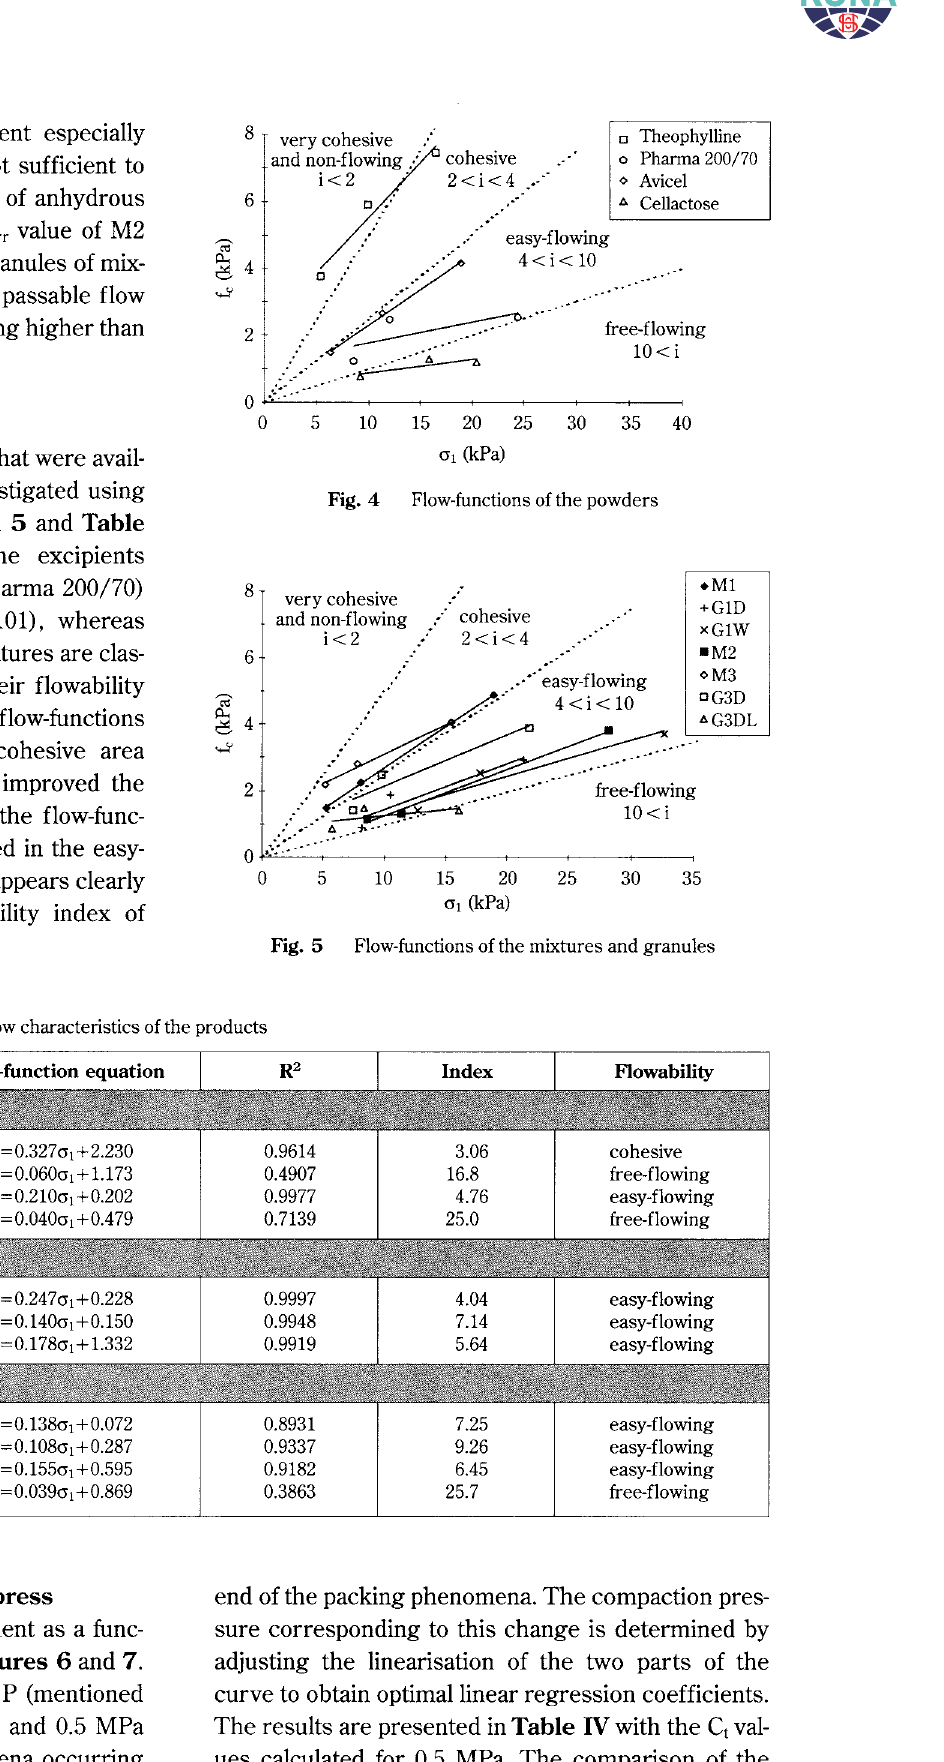
Dry granules 1 (GlD) Wet granules 1 (G1W) Dry granules 3 (G3D) Lubricated dry granules 3